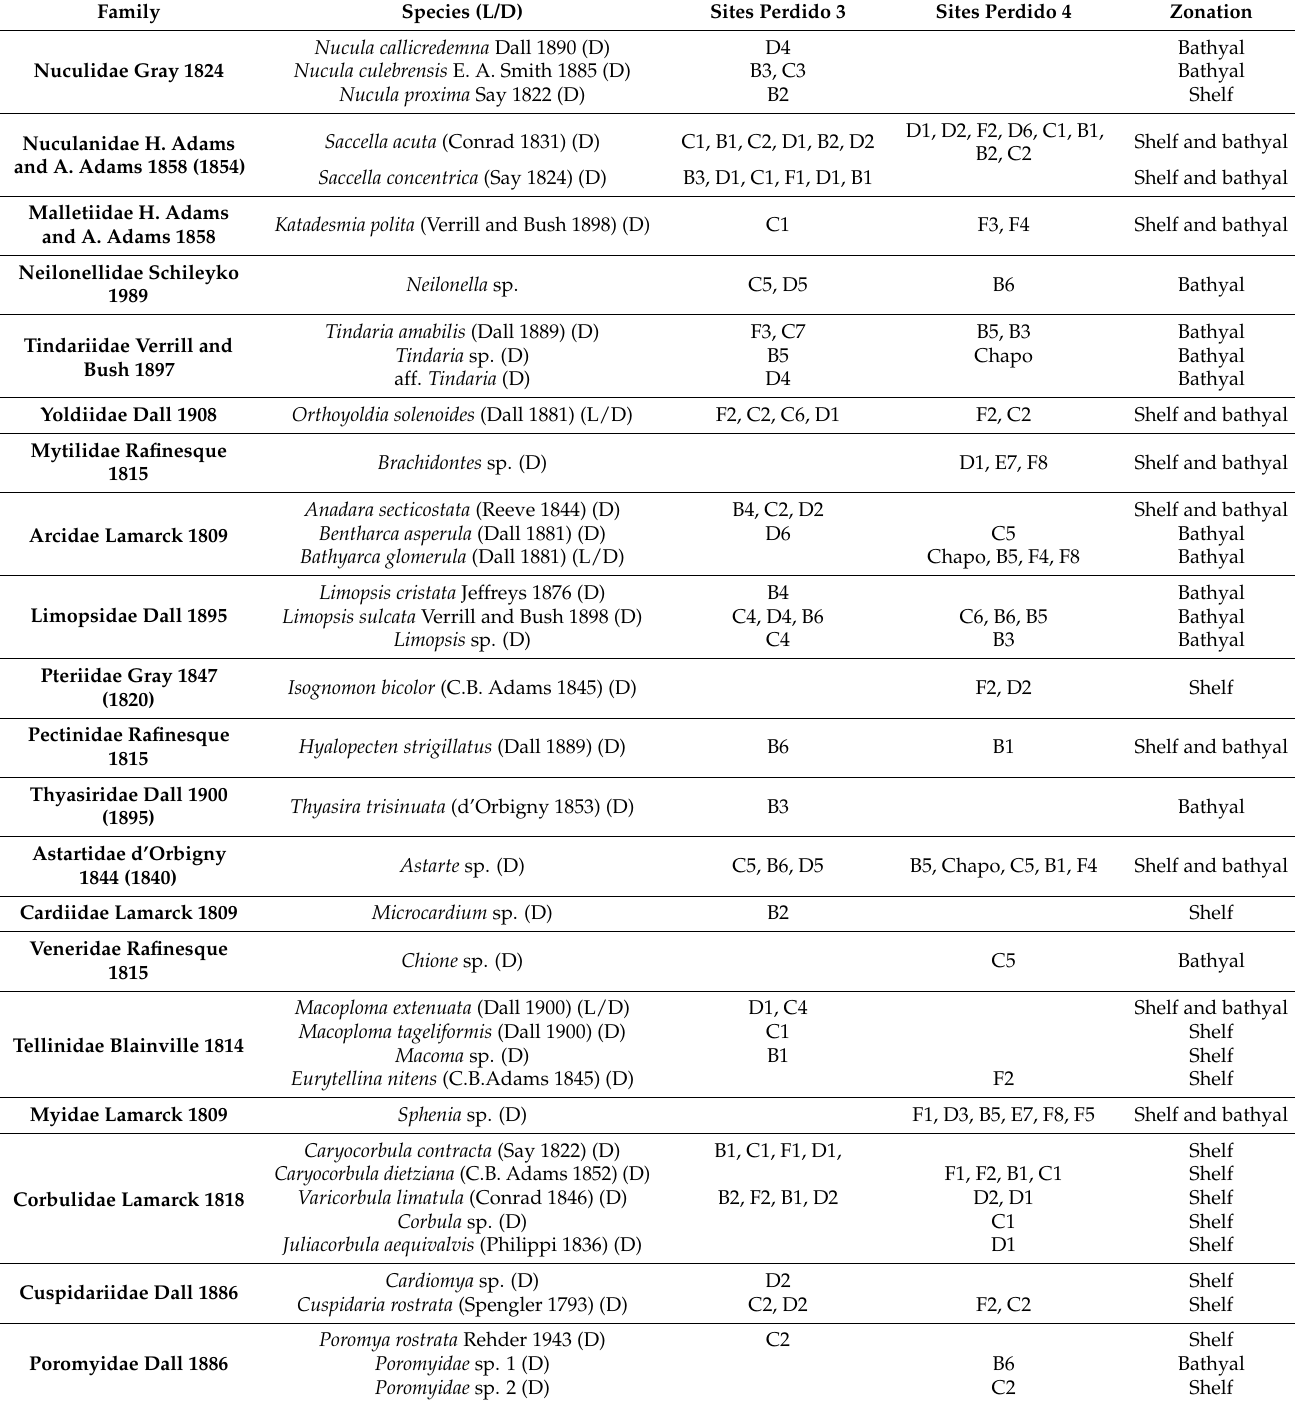
Table 2. List of the 20 bivalve families and 39 species collected during the Perdido 3 and 4 cruises, live (L) whole animal with two valve and with soft parts, versus dead (D), i.e., the shell only. Details on stations and scientific collection vouchers for each specimen can be found in Appendix